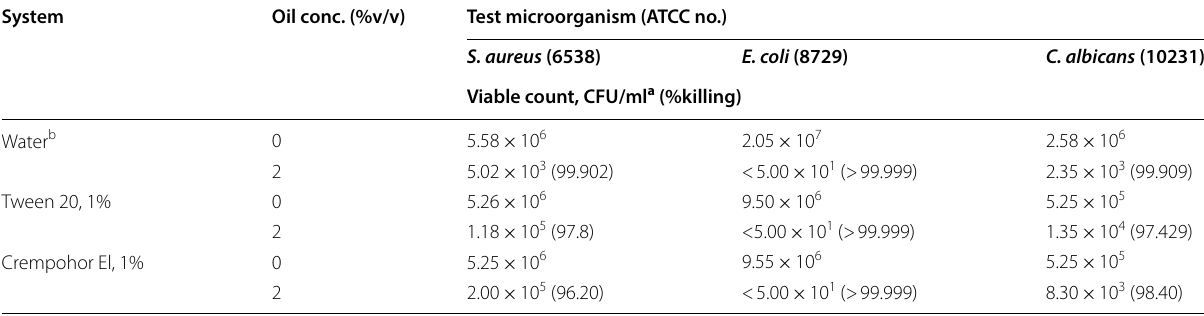
a Average of three determinations carried out by surface viable method after 5 min at RT (24 °C) b The system was intermittently vortexed for 5 min